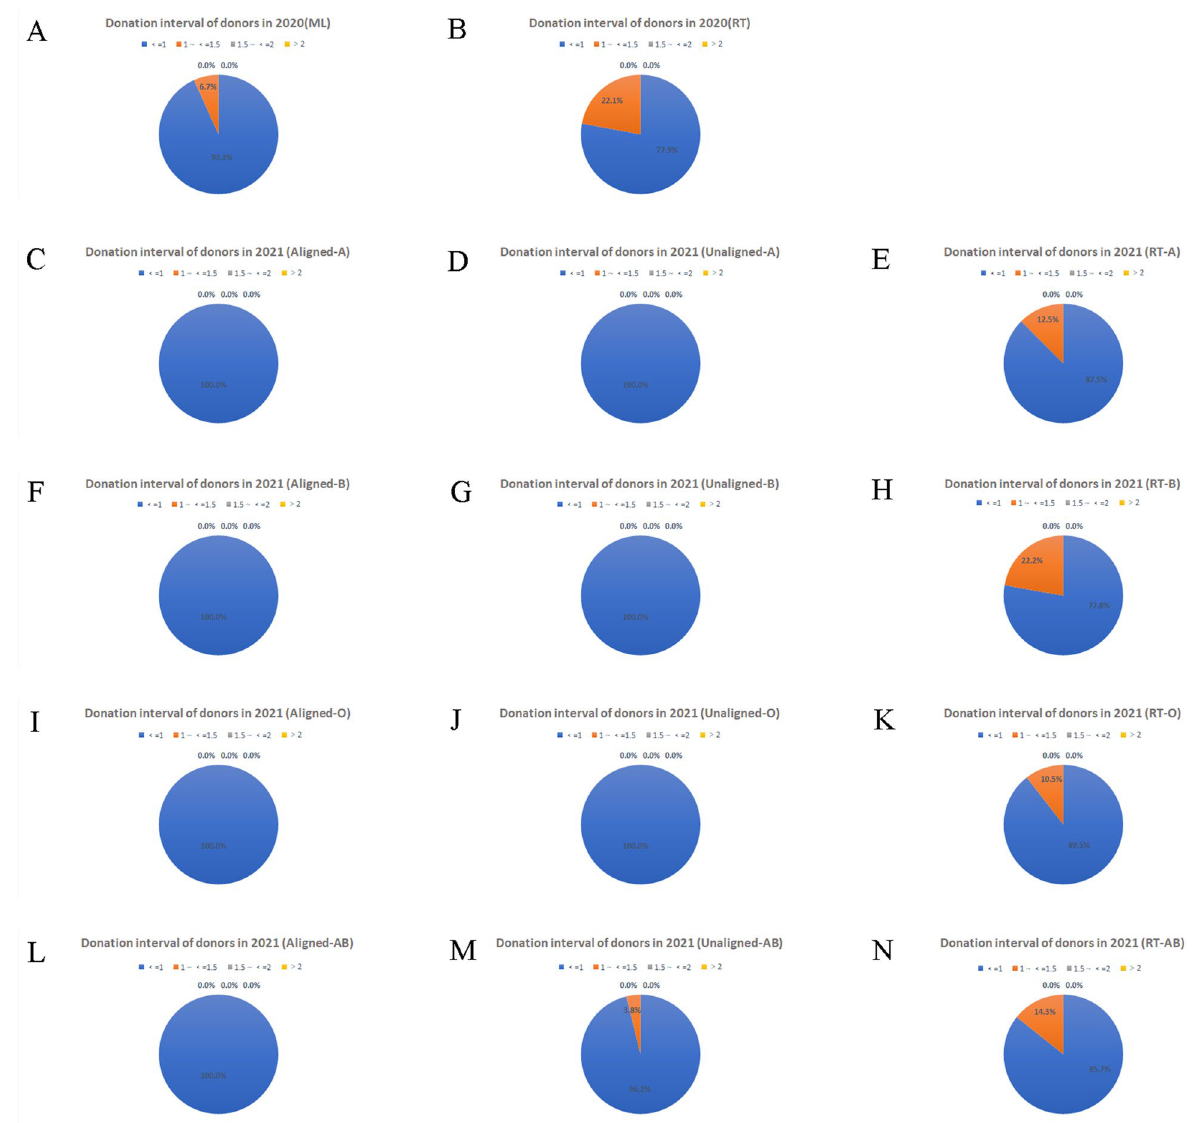
Figure 5. Statistics of donation interval (year) in pandemic recruitment. The interval characteristics of blood donors recruited were analyzed, donors with short intervals made up the majority of donors successfully recruited during the pandemics. ( A ) Donation interval of donors in 2020 (ML). ( B ) Donation interval of donors in 2020 (RT). ( C ) Donation interval of donors in 2021 (Aligned-A). ( D ) Donation interval of donors in 2021 (Unaligned-A). ( E ) Donation interval of donors in 2021 (RT-A). ( F ) Donation interval of donors in 2021 (Aligned-B). ( G ) Donation interval of donors in 2021 (Unaligned-B). ( H ) Donation interval of donors in 2021 (RT-B). ( I ) Donation interval of donors in 2021 (Aligned-O). ( J ) Donation interval of donors in 2021 (Unaligned-O). ( K ) Donation interval of donors in 2021 (RT-O). ( L ) Donation interval of donors in 2021 (Aligned-AB). ( M ) Donation interval of donors in 2021 (Unaligned-AB). ( N ) Donation interval of donors in 2021